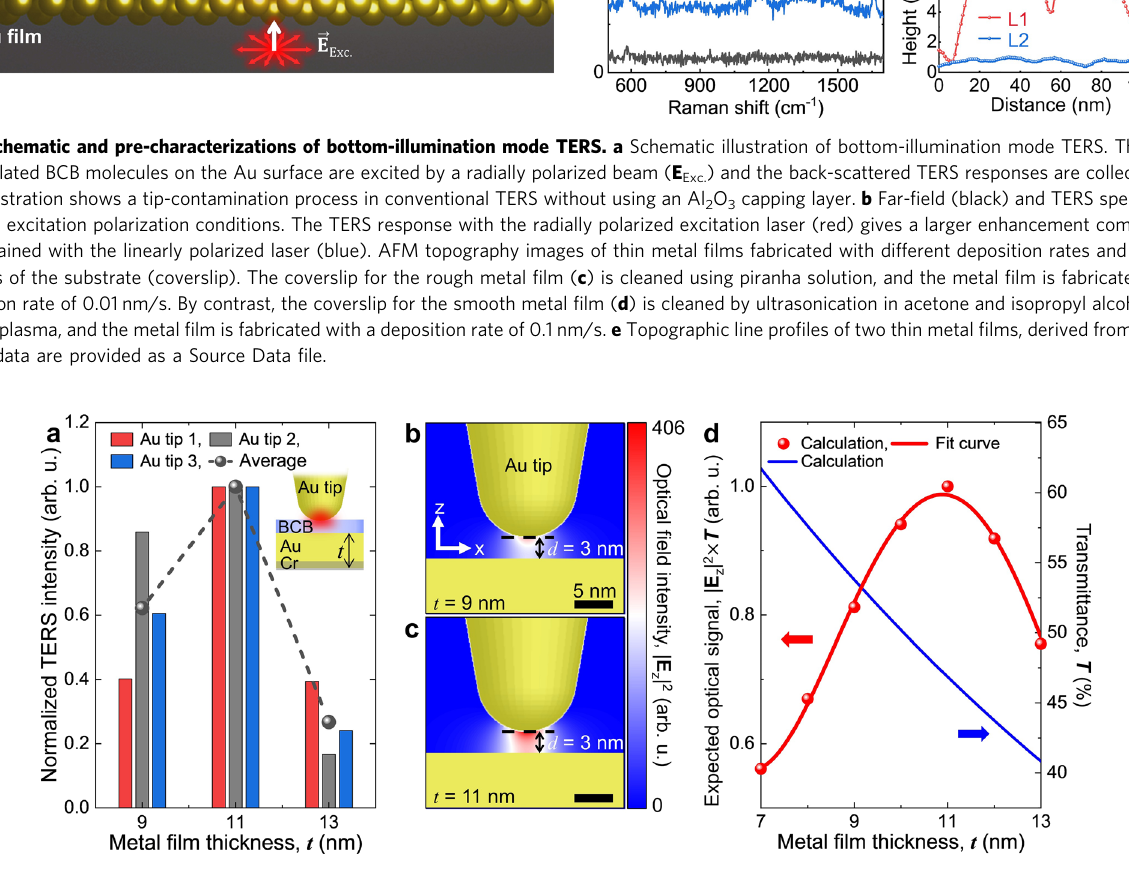
Fig. 2 TERS enhancement comparison for different metal fi lm thickness. a Comparison of TERS intensity of BCB molecules for the metal substrates with different thicknesses ( t = 9, 11, and 13 nm). The ratio of tip-enhanced and tip-retracted Raman intensities of the ~580 cm − 1 peak is measured for different substrates with three different tips. The obtained intensity ratios for the three different tips are normalized to [0, 1] for comparison of the thickness effect. (cid:1) (cid:1) (cid:1) (cid:1) 2 ) distribution at the nano-gap between the Au tip and the The black circles show average values for three tips. FDTD-simulated optical fi eld intensity ( E z thin metal fi lm with a fi lm thickness of 9 nm ( b ) and 11 nm ( c ). d Expected optical signal (red circles) in the bottom-illumination mode and theoretically calculated transmittance (blue) with respect to the thickness of the metal fi lm. The expected optical signal is calculated by the FDTD-simulated optical fi eld intensity at the nano-gap multiplied by transmittance ( T ) at each fi lm thickness. The derived result of the expected optical signal as a function of the metal fi lm thickness is fi t with a 4th degree polynomial (red line). T is calculated with the equation (1). Source data are provided as a Source Data fi